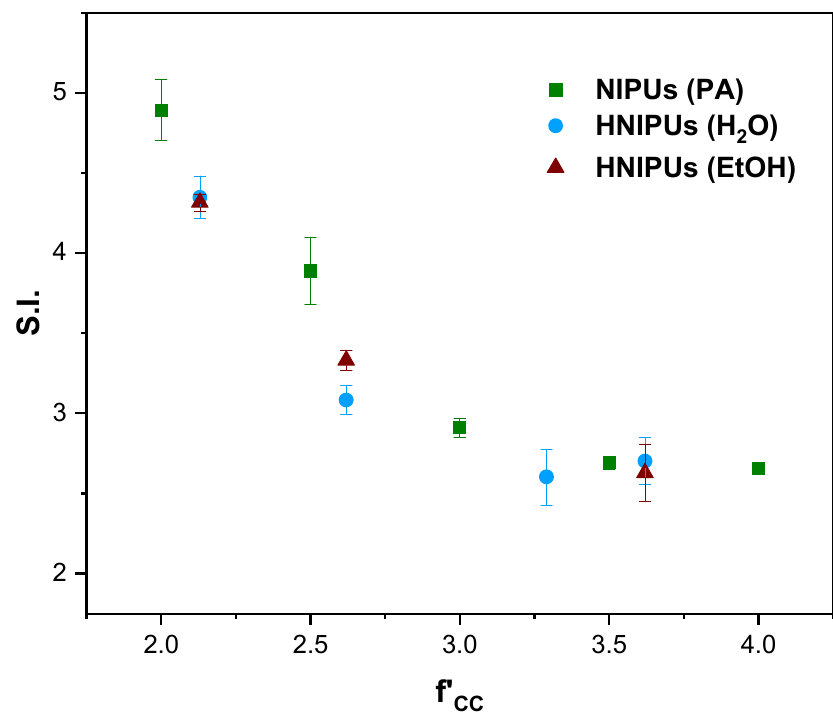
Figure 11. Swelling index comparative results of NIPU – HNIPUs.